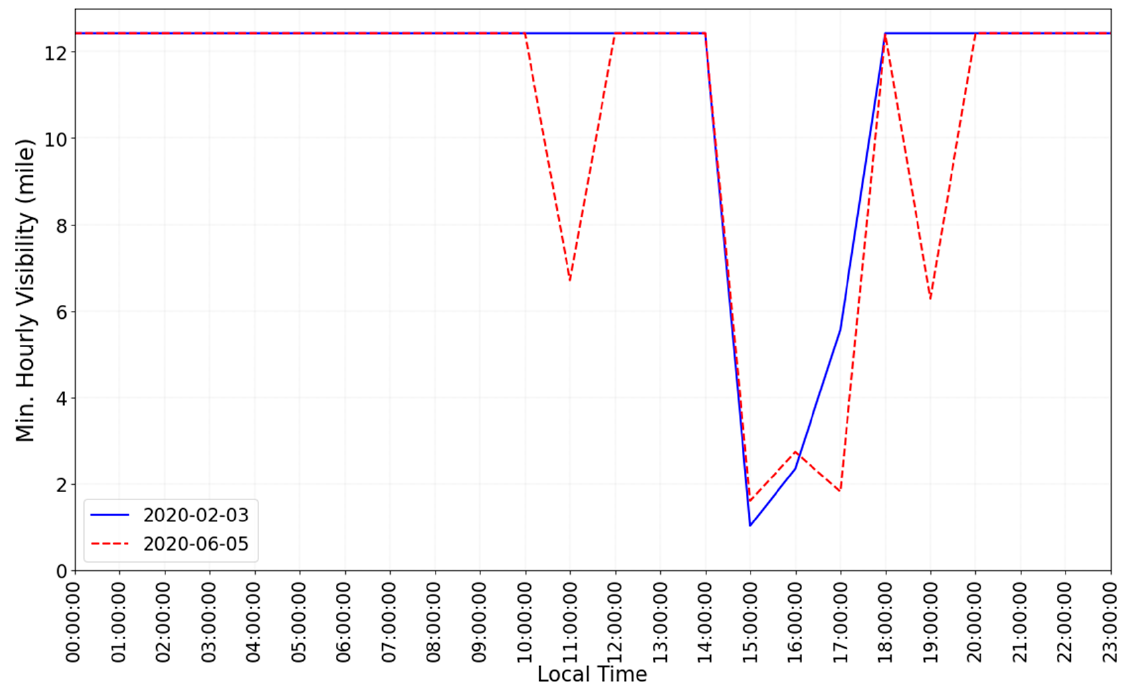
Figure 14. Minimum hourly visibility for the dust event days of 3 February 2020 and 5 June 2020 from the NM003 meteorological station.